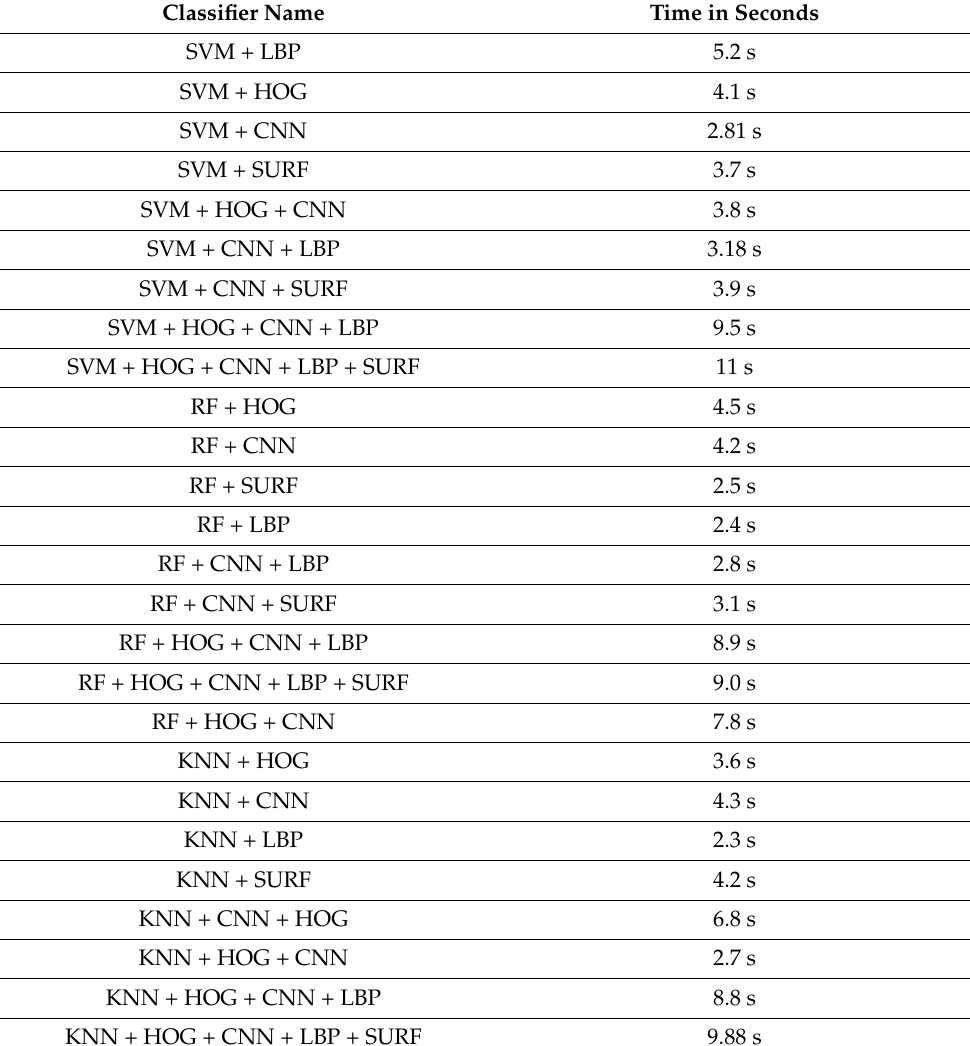
Table 2. Training Time for the Proposed